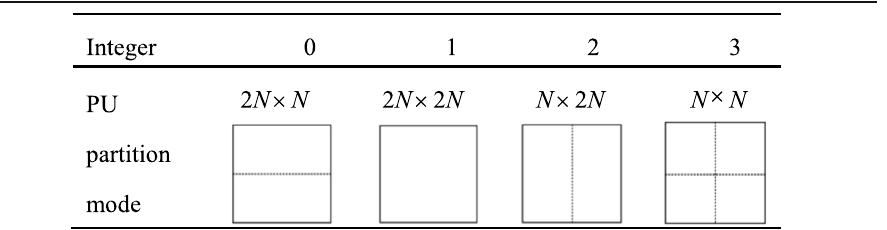
Table 10 Mapping 2 of PU partition modes for 8×8-sized